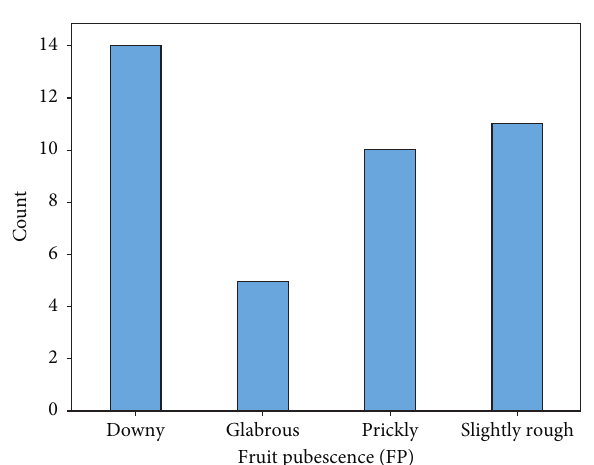
Figure 5: Variation in fruit pubescence in forty genotypes of